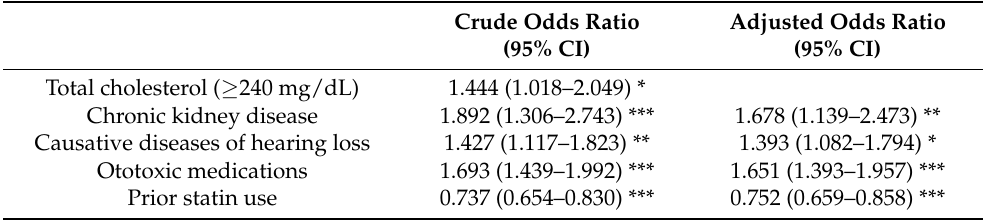
Table 3. Univariate and multivariable logistic regression analyses for sensorineural hearing loss or